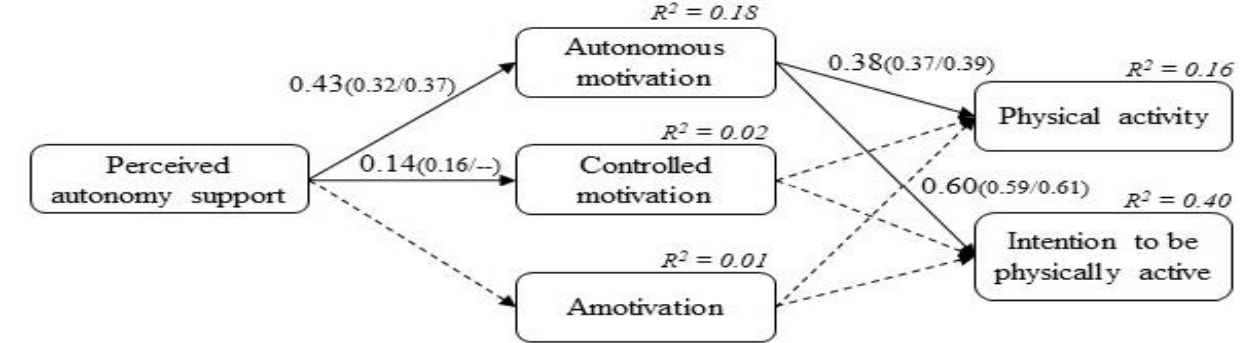
Figure 2. SEM of the alternative model for the full sample and for boys (first coefficient in brackets) and girls (second coefficient in brackets). Note: Coefficients are standardized and statistically significant at 0.05 level. As in Figure 1, relationships that were not statistically significant were not shown for reasons of parsimony. Following, R coefficients are shown for the relationship between autonomous motivation and controlled motivation (r = 0.24, p < 0.001; r = 0.22, p < 0.001 for boys, and r = 0.24, p = 0.001 for girls), between autonomous motivation and amotivation (r = 0.01, p = 0.935; r = 0.01, p = 0.936, and r = 0.04, p = 0.879 for girls), and the relationship between controlled motivation and amotivation (r = 0.77, p < 0.001; r = 0.77 p < 0.001 for boys, and r = 0.78, p = 0.001 for girls). Non-significant paths were indicated with dashed lines.